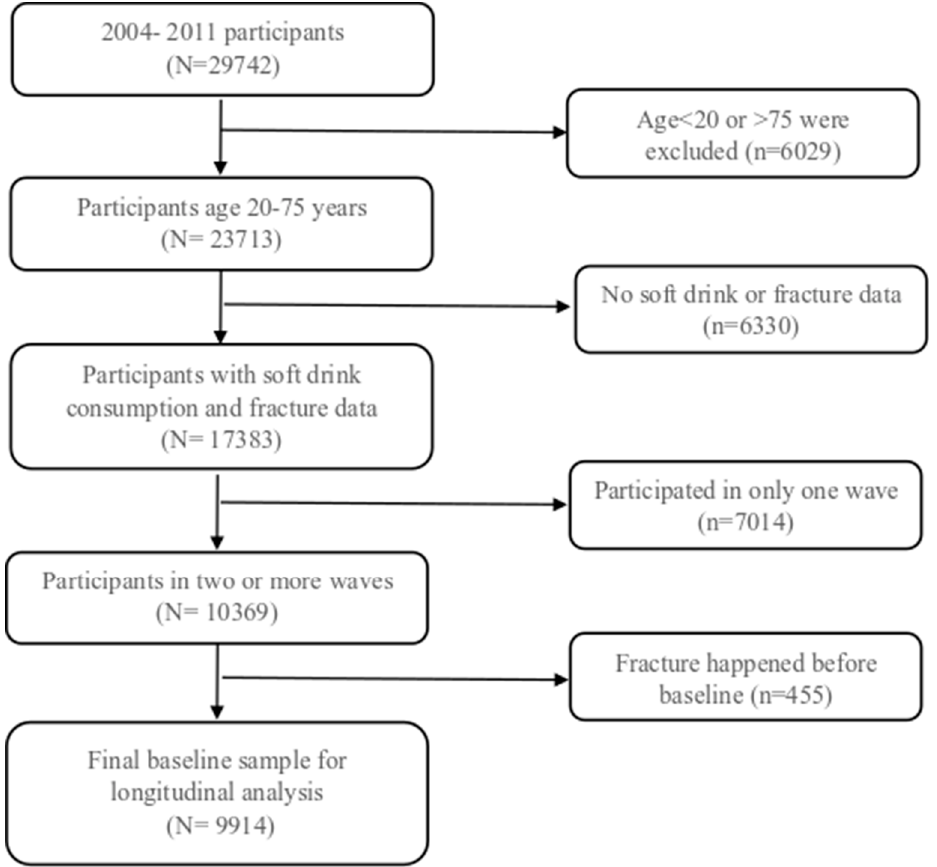
Figure 1. Sample flowchart.